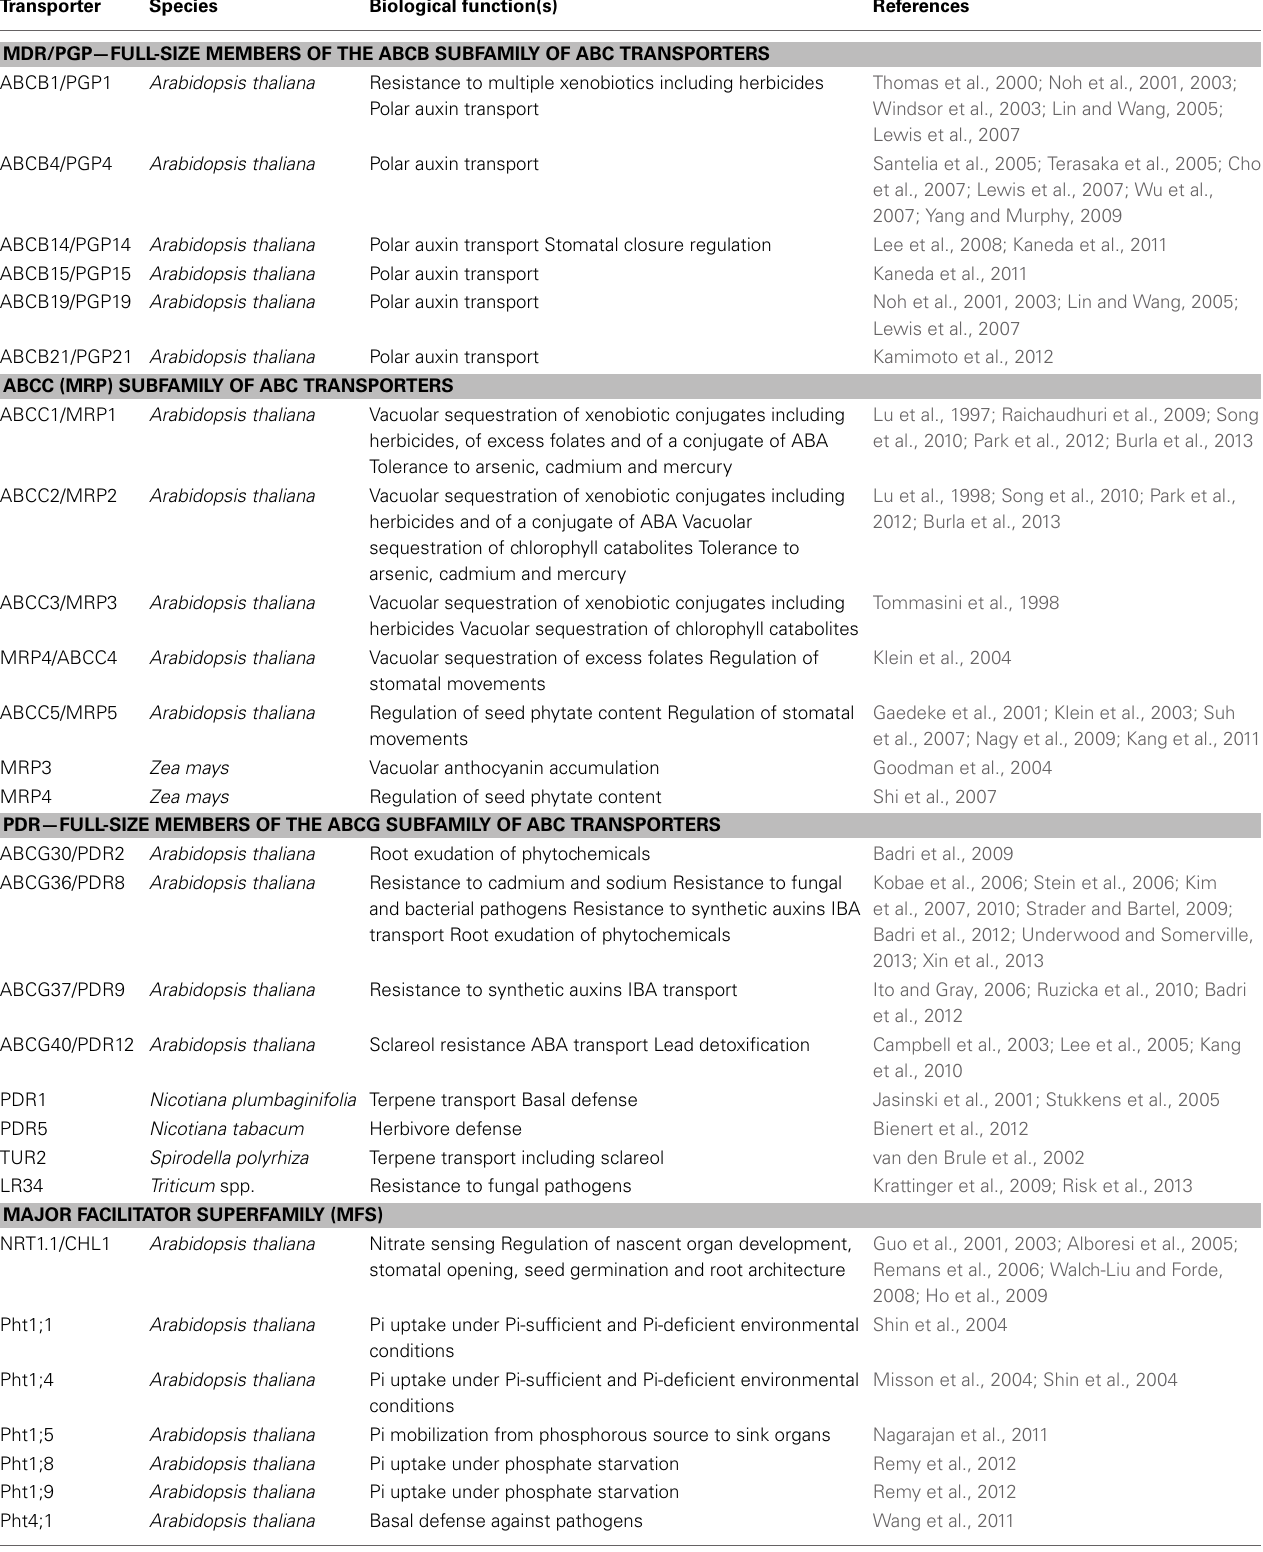
Table 1 | Representative examples of plant MDR transporter homologs and their physiological functions.